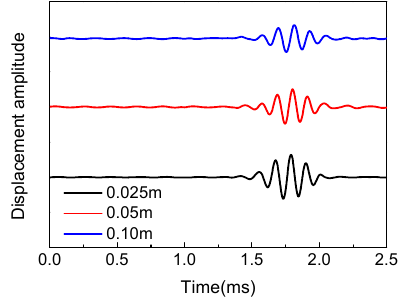
Figure 10. Time-domain waveforms with respect to time for various thicknesses of porous medium layer ( β = 0.1). Black, red and blue lines represent layer thickness d = 0.025, 0.05, and 0.10 m, respec-